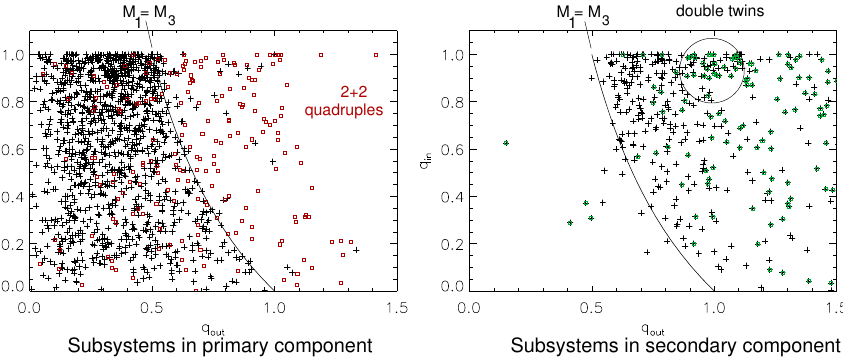
Figure 5. Relation between inner and outer mass ratios q in = M 2 / M 1 and q out = M 3 / ( M 1 + M 2 ) . The left panel shows subsystems belonging to the primary components, the right panel—to the sec- ondary components; crosses correspond to single outer components and squares to outer components that also contain subsystems. The black line marks outer twins with M 1 = M 3